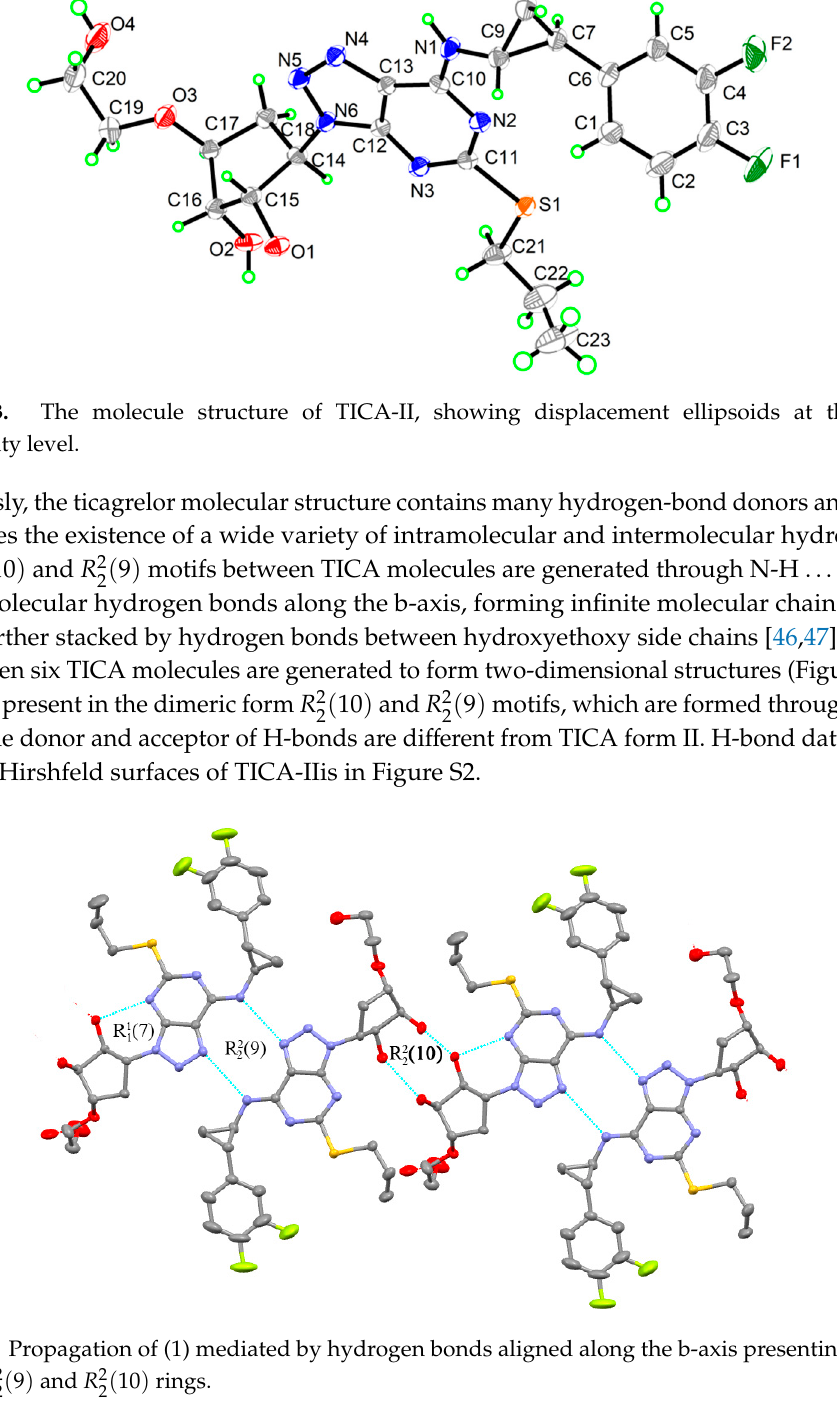
Figure 4. Propagation of (1) mediated by hydrogen bonds aligned along the b-axis presenting fused 𝑅 11 (7) , 𝑅 22 (9) and 𝑅 22 (10) rings. Table 2. Hydrogen-bond of TICA - II (Å, °).